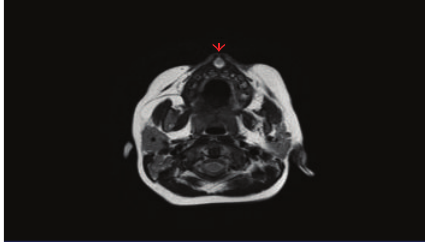
Figure 2: Magnetic resonance imaging shows the lesion that prevented the fusion of orbicularis oris muscles in the midline of the upper lip.